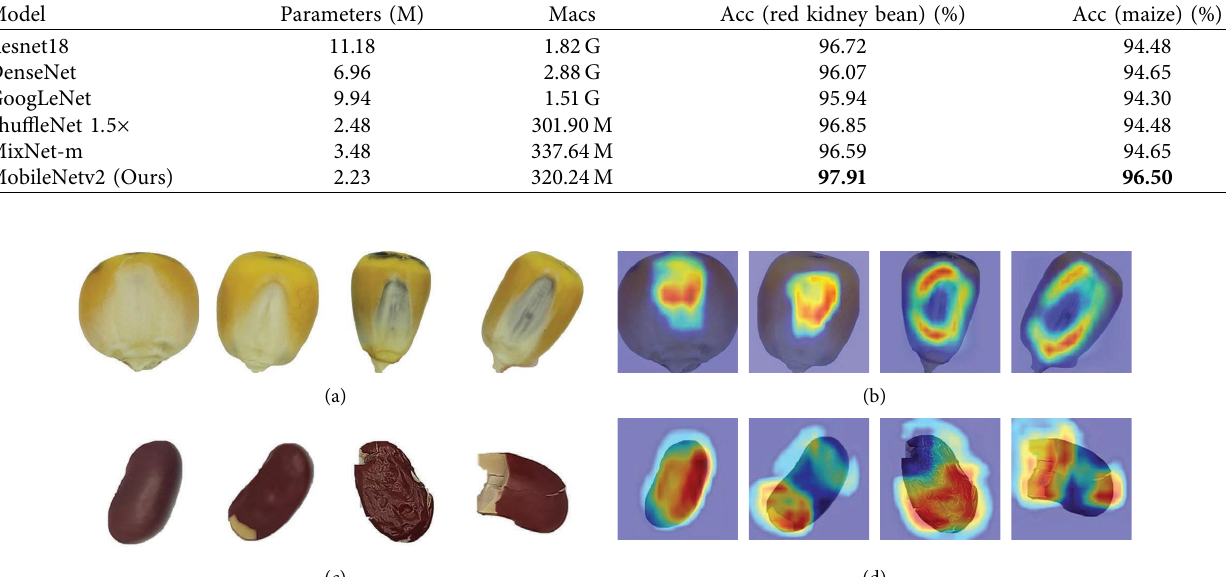
Table 3: Performance of some popular CNN in red kidney bean and maize test sets.